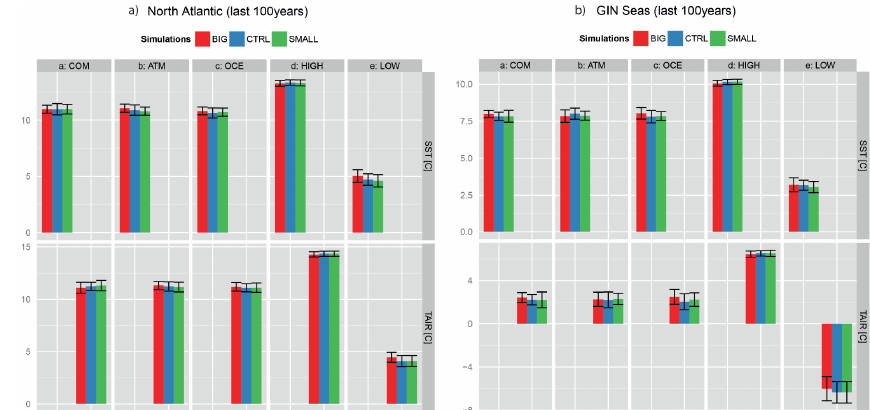
Figure 4. Mean + standard deviation of the last 100 years of the performed experiments: sea surface temperature (SST, ◦ C) and air tem- perature (TAIR, ◦ C); red = BIG icebergs, blue = CTRL, green = SMALL icebergs; (a) North Atlantic: mean computed over: 45–60 ◦ N and 60–20 ◦ W; (b) Greenland–Iceland–Norwegian (GIN) seas: 50–85 ◦ N and 45 ◦ W–15 ◦